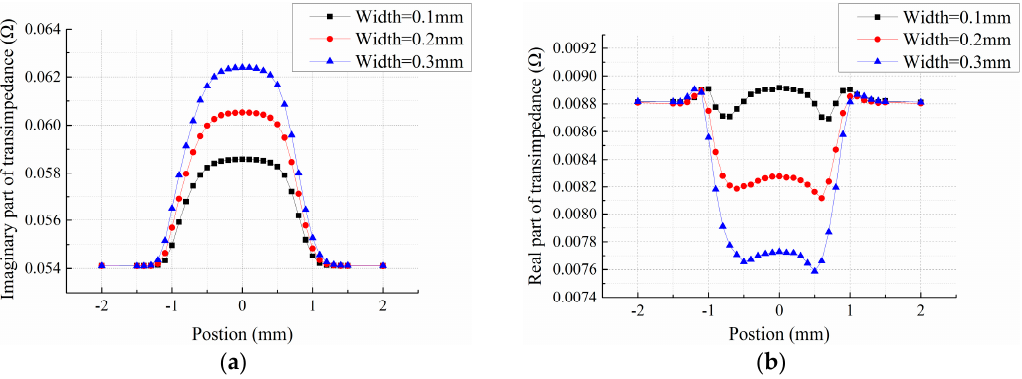
Figure 4. ( a ) Imaginary part; ( b ) Real part. Of sensor transimpedance in vertical scanning mode for cracks with different width.